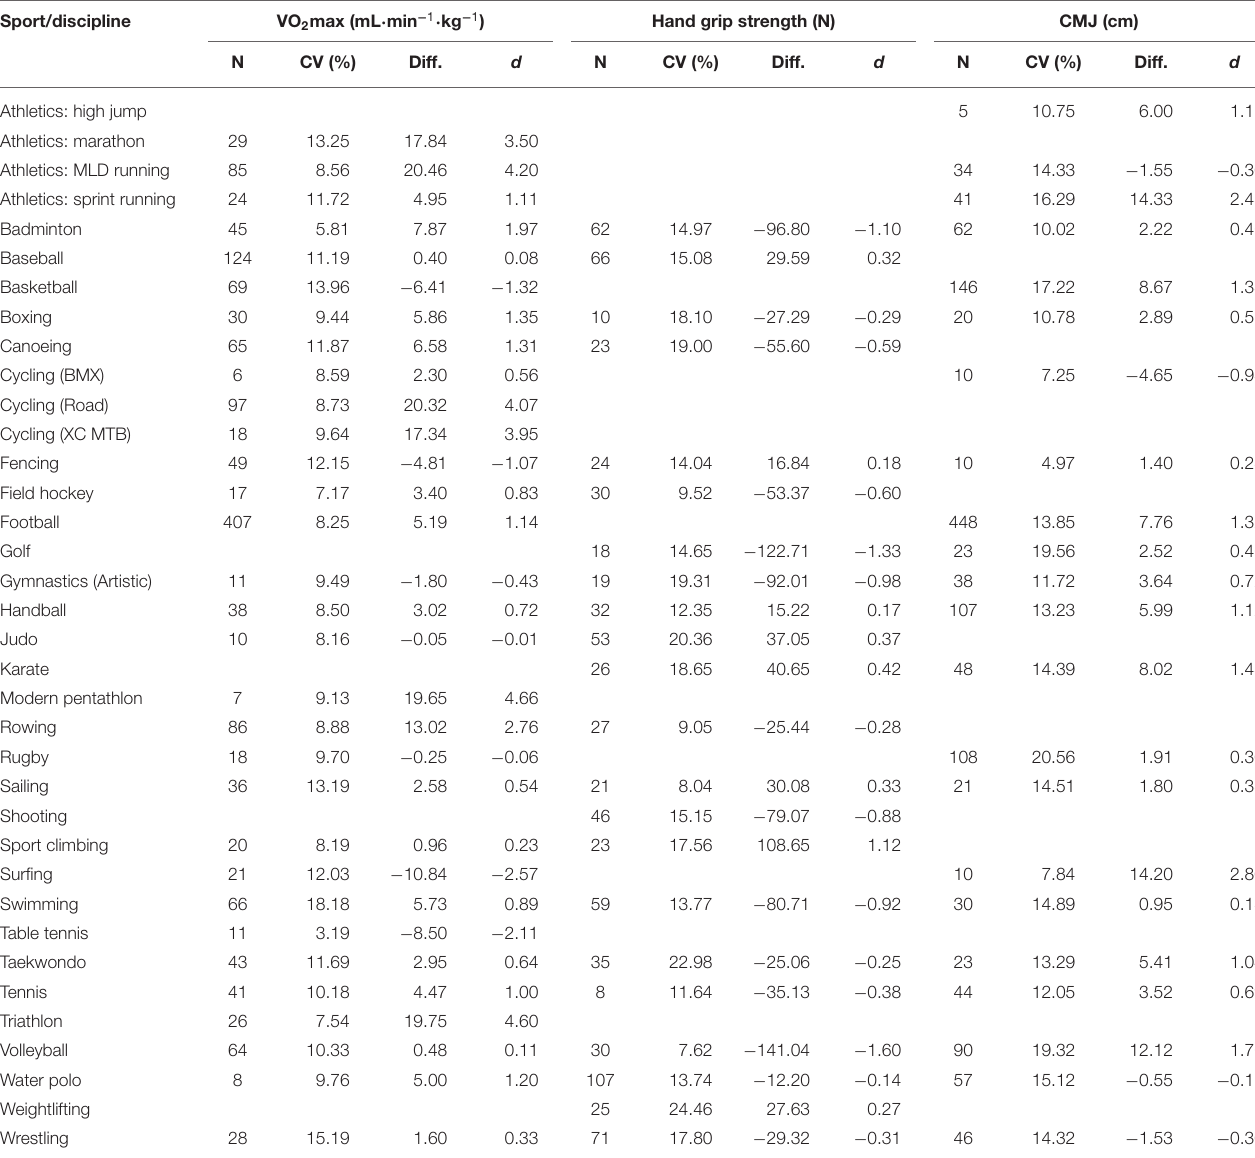
TABLE 3 | Number of athletes included per sport, Coefficient of Variation (CV) within sport, difference between the mean of each sport and the special operations police unit, and effect size ( d ) for maximum oxygen uptake (VO 2 max), hand grip strength and countermovement jump height (CMJ).